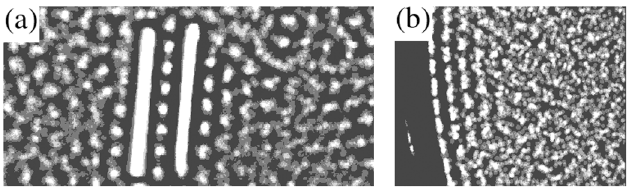
wall is vertical and smooth (no spheres embedded on the